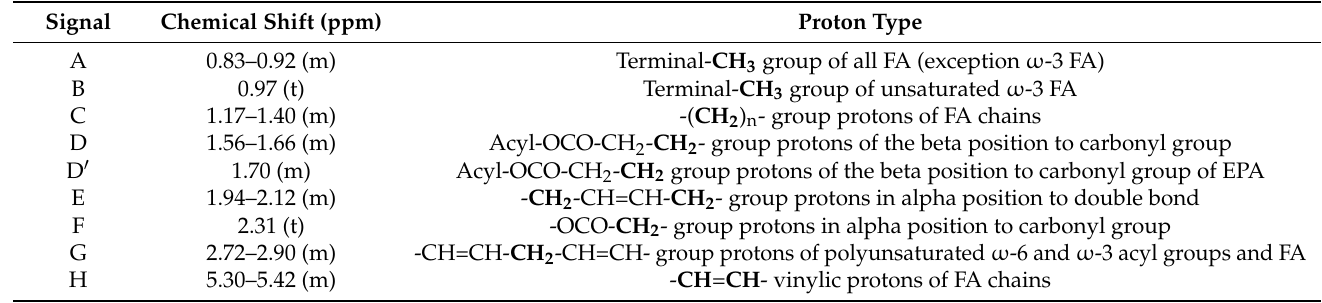
Table 1. FA characteristic chemical shift values observed in the 1 H-NMR spectrum.